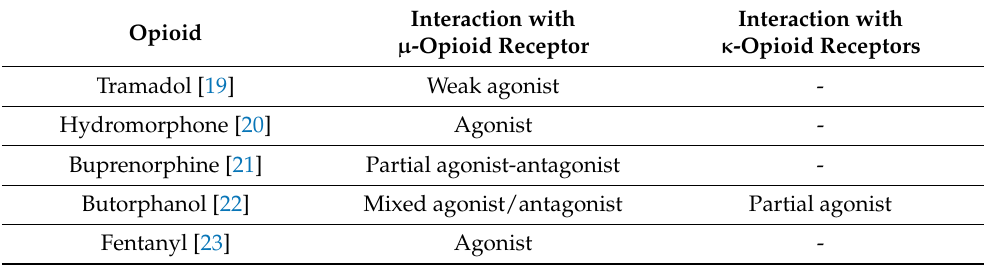
Table 1. The interactions of selected opioids with µ - or κ -opioid receptors and their classification. Interaction with Interaction with Opioid µ -Opioid Receptor κ -Opioid Receptors Tramadol [19] Weak agonist - Hydromorphone [20] Agonist - Buprenorphine [21] Partial agonist-antagonist - Butorphanol [22] Mixed agonist/antagonist Partial agonist Fentanyl [23] Agonist